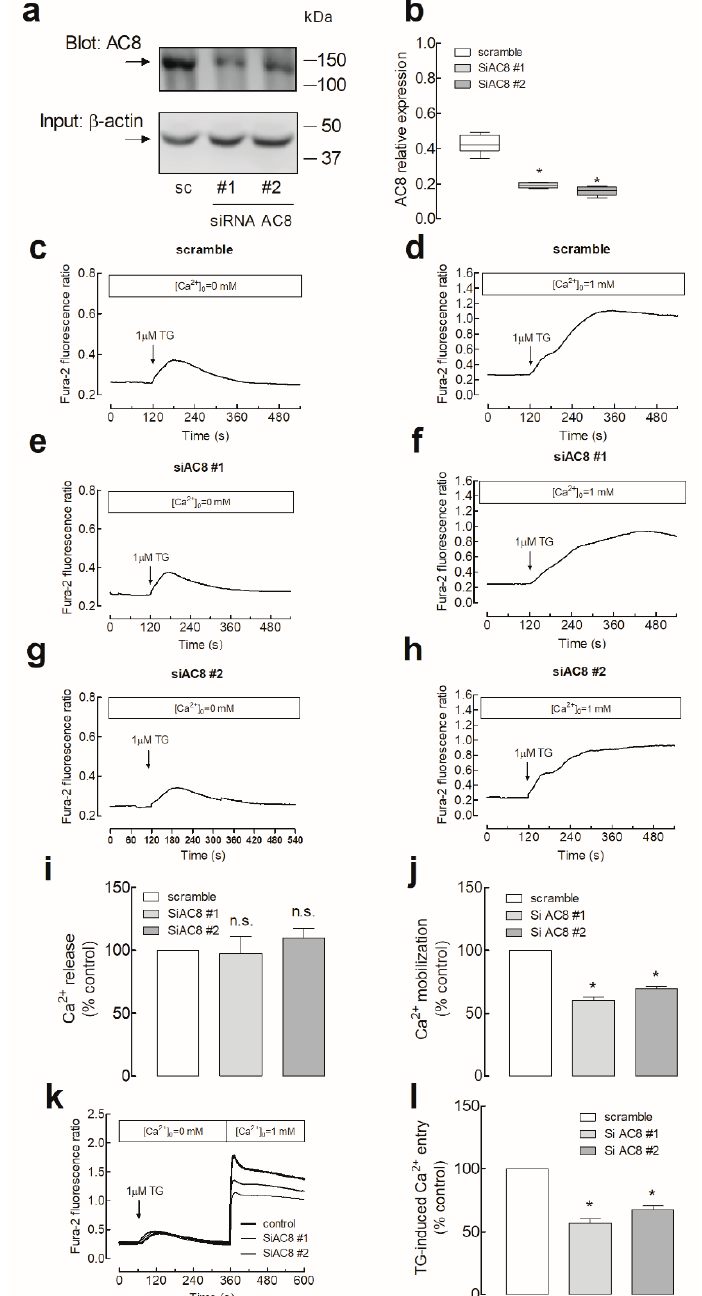
Figure 4. AC8 is required for full store-operated Ca 2+ entry activation in MDA-MB-231 breast